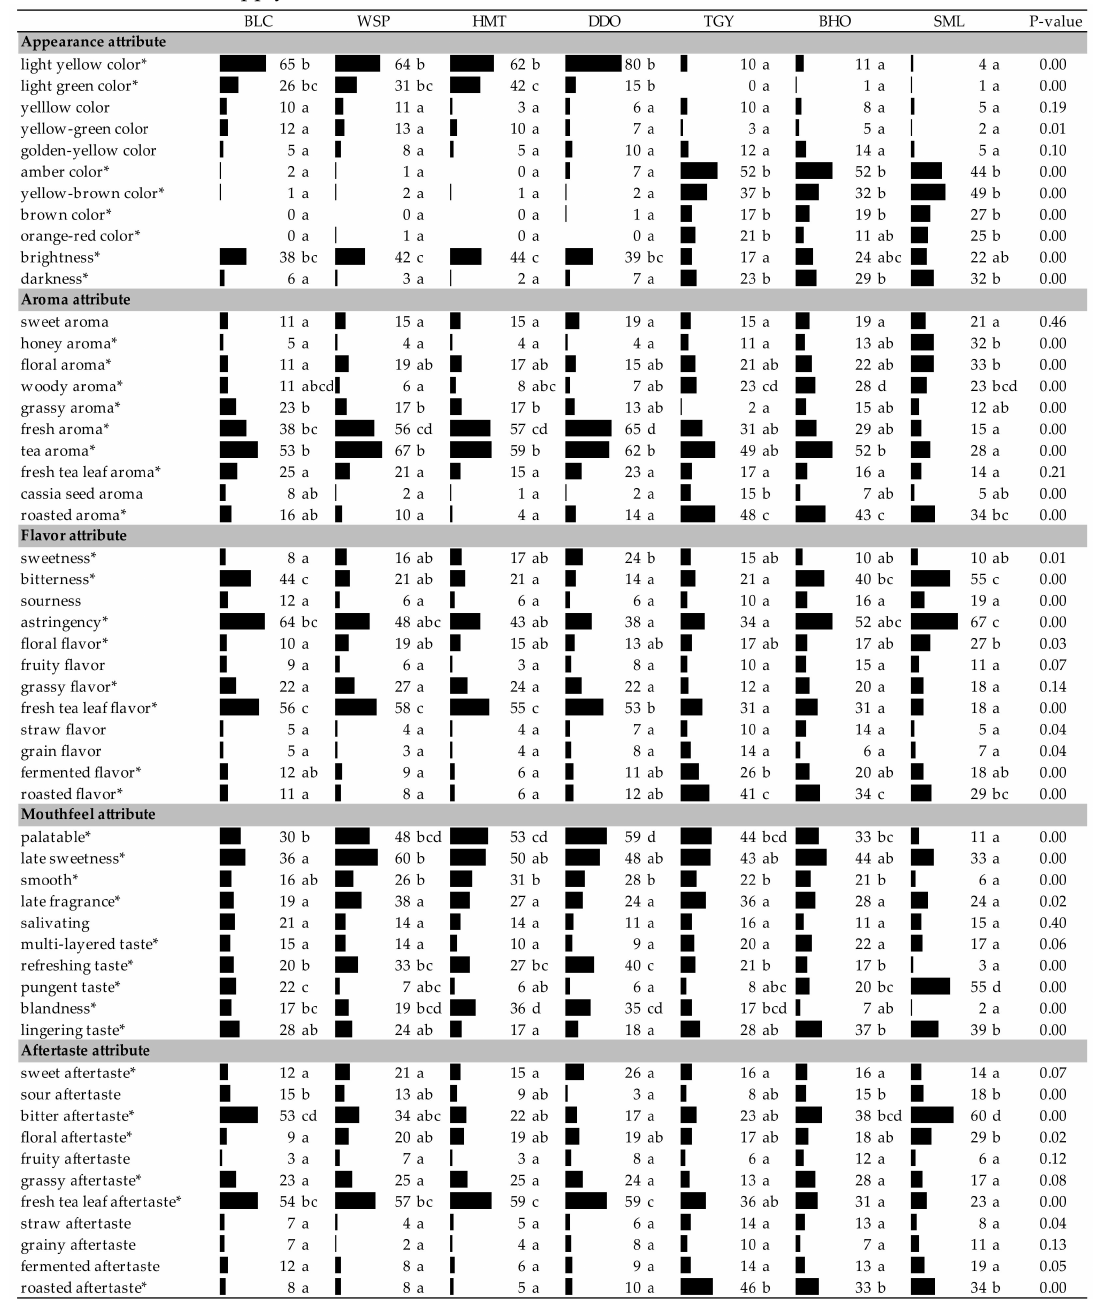
Table 2. Selection frequencies of sensory attributes for the Taiwanese specialty tea infusions based on the check-all-that-apply (CATA) method ( n =